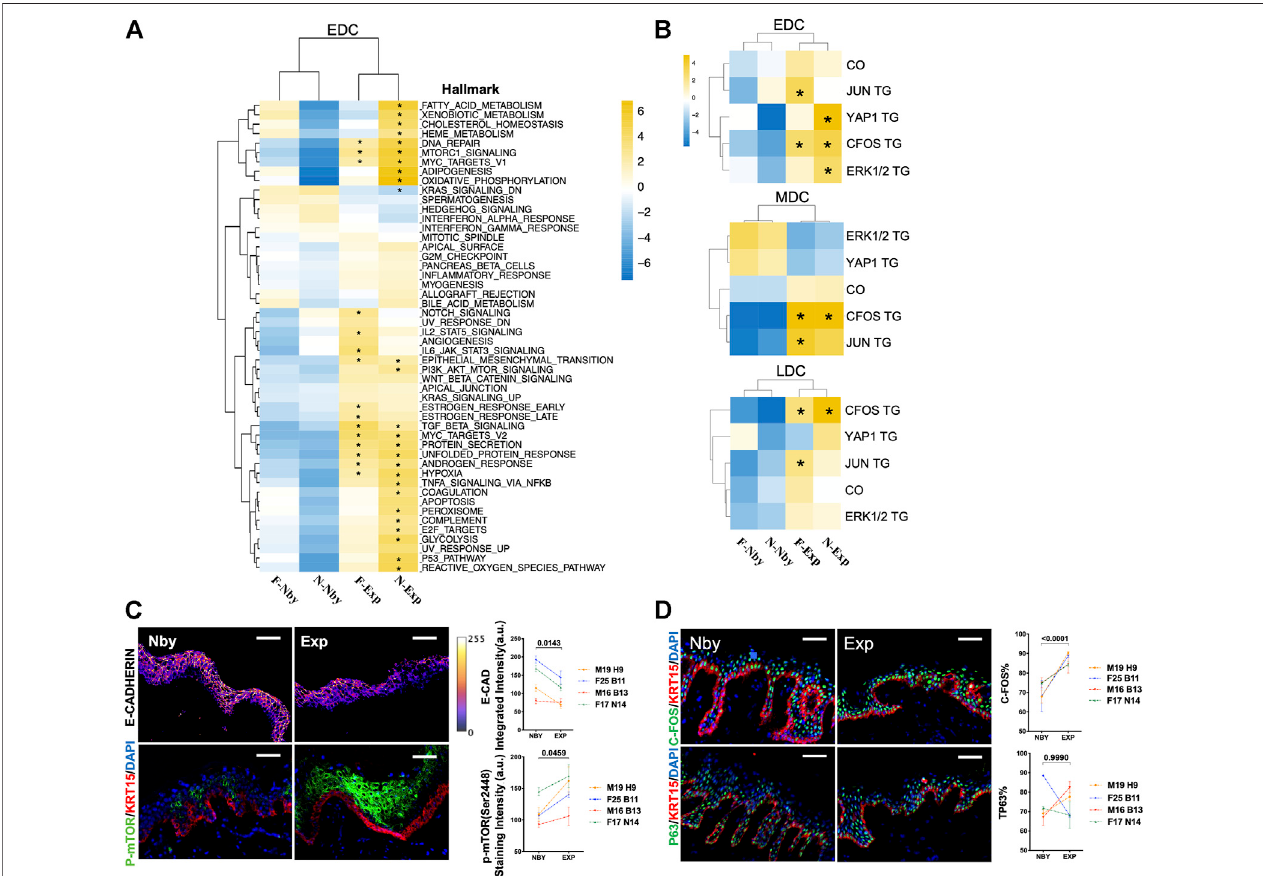
FIGURE 4 | Changes in the transcriptional pro fi les of the EDC subpopulation during LTE. (A) Heatmap showing the GSEA results of the MSigDB hallmark terms in EDCinfoursamples. p < 0.05isconsideredstatisticallysigni fi cant,sameinallfollowing fi guresunlessotherwisementioned. (B) HeatmapshowingtheGSEAresultsinof the previously published TGs of the transcriptional factors JUN, C-FOS, YAP1, and ERK1/2 cascade downstream signatures and GO terms of cytoskeleton organization. (C) RepresentativeimagesoftheE-CADandp-mTORstaininginnbyandexpsamplesfromfourotherindividualsandtheirquanti fi cation.TheE-CAD IF staining intensity was shown by the pseudo-color integrated density signal. The color key (right) from purple to yellow indicates low to high integrated density signal levels. A.U, arbitrary units. (D) Representative IF images of the C-FOS and P63 staining in nby and exp skin and their quanti fi cation.